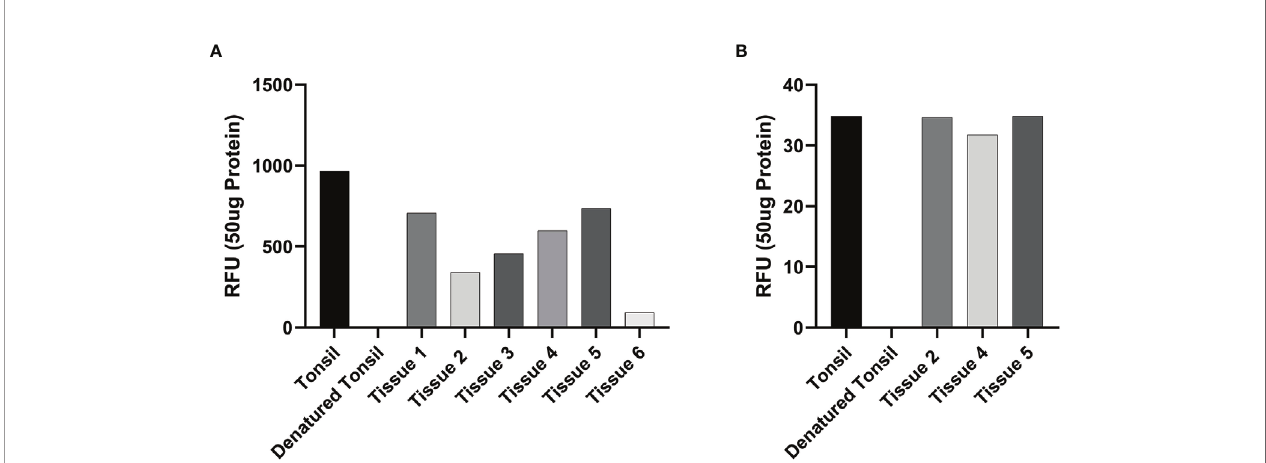
FIGURE 5 | Averages for the enzymatic activity assays of metastatic cutaneous head and neck squamous cell carcinoma (mHNcSCC) tissue samples for cathepsin B and cathepsin D This showed cathepsin B (A) in all six tissue samples and cathepsin D (B) in all 3 samples were active, relative to the positive (tonsillar) and negative (denatured tonsillar) control tissues. Their activity is expressed as relative fl uorescent unit